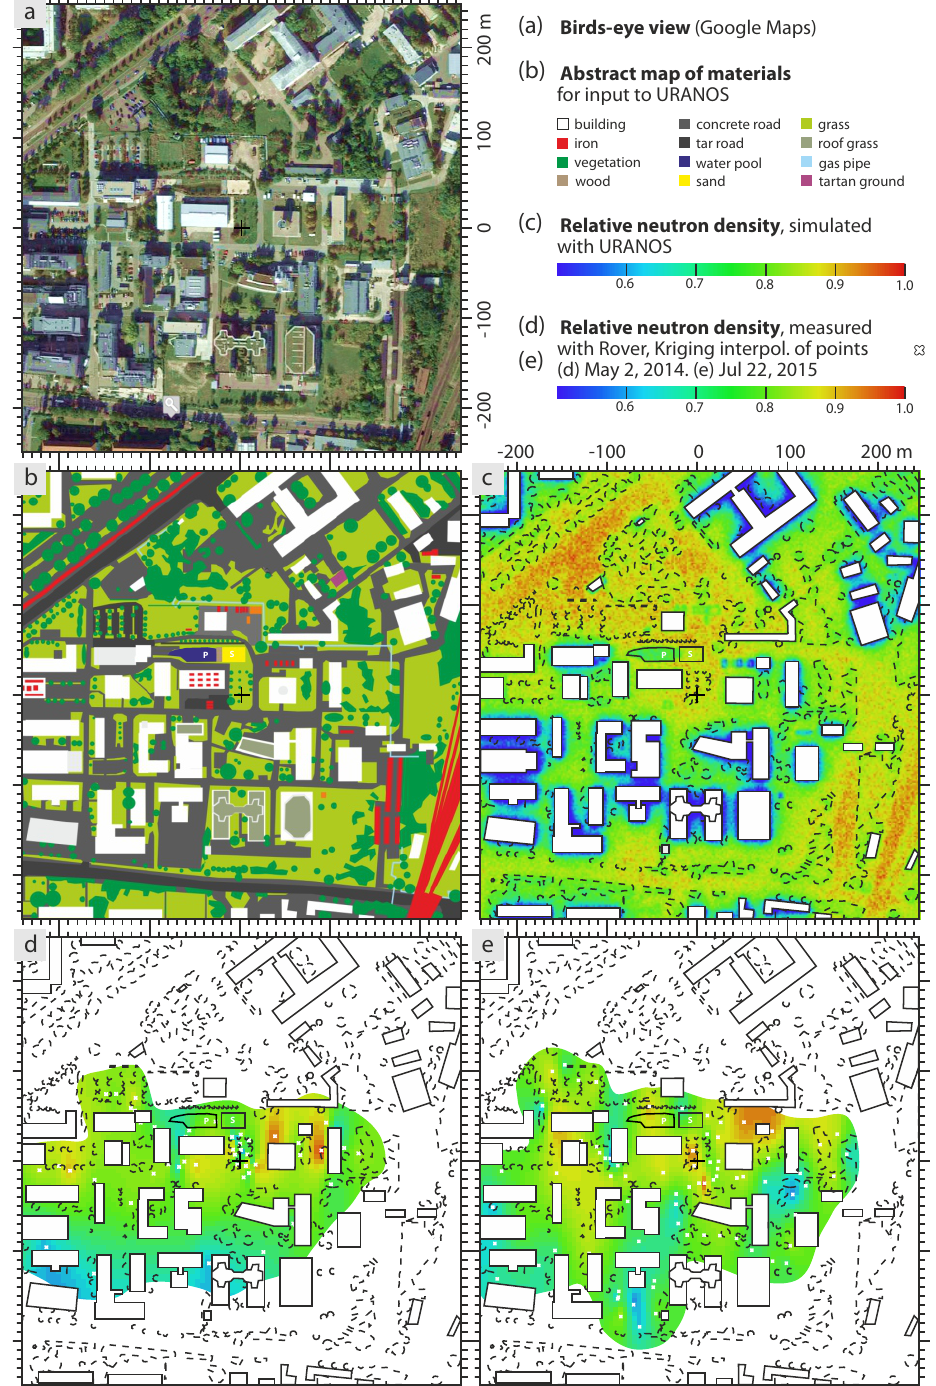
Figure 8. (a) Neutron environment of the urban CRNS test site (centred black cross). (b) Abstract model of the area using geometric shapes and colour-coded material definitions. (c) URANOS simulation of epithermal neutrons in a detector layer above the surface. (d, e) Measured neutrons with the mobile CRNS rover confirm heterogeneity of neutron patterns in the centred grass meadow as well as in the surrounding urban